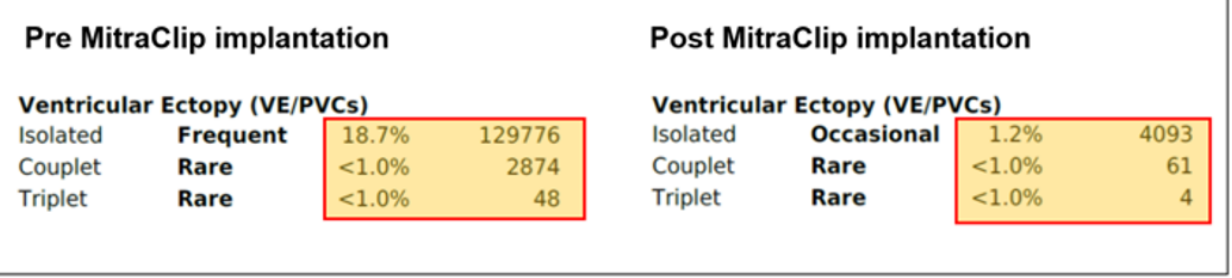
Figure 5. Case 2: Overview of the ventricular ectopies recorded by Zio XT patch monitoring (iRhythm Technologies, San Francisco, CA, USA) pre-MitraClip ( left ) and post-MitraClip XTR implantation at 1-year follow-up ( right ). PVCs: premature ventricular contractions.